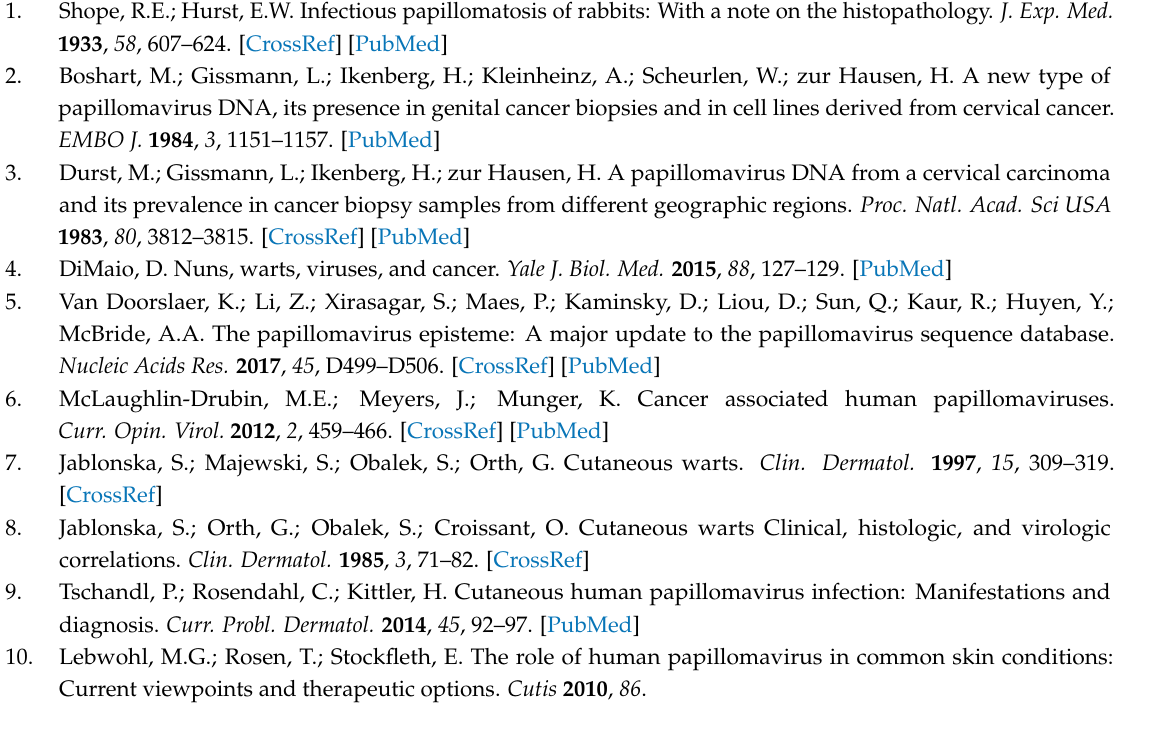
Figure S1: E6 amino acids of rodent papillomaviruses from Table 1 were aligned in JalView (software version: 2.9.0b2, The Barton Group, University of Dundee, Scotland, UK) [250] using the ClustalX algorithm. Two zinc-like finger domains with consensus sequence CX2C-X29-CX2C are highlighted. Numerous PDZ binding site motifs (XS/TXV, magenta box) were seen throughout the E6 sequence. The Rb binding motif (LXCXE, white box) was seen in MmuPV1 and MnPV1. Figure S2: E7 amino acids of Rodent Papillomaviruses from Table 1 were aligned in JalView [250] using the ClustalX algorithm. One zinc-like finger domain with consensus sequence CX2C-X29-CX2C was seen near the C-terminus. Numerous PDZ binding site motifs (XS/TXV, magenta box) were seen throughout the E7 amino acid sequence of rodent PVs. Rb binding motif (LXCXE, white box) was seen in MnPV1, RnPV2 and